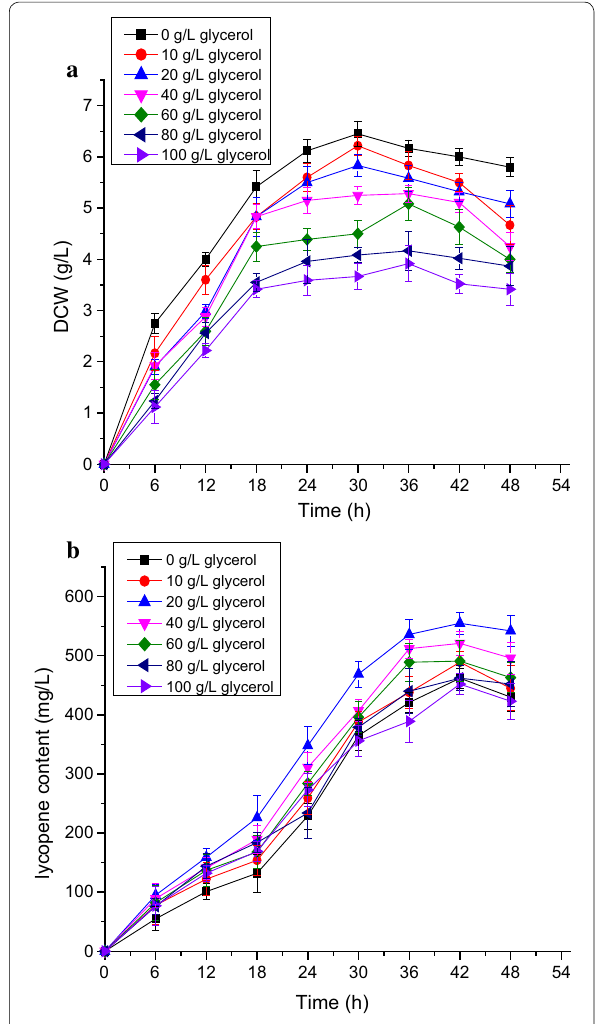
Fig. 5 Dry cell weight and lycopene yield of strain EBI with different initial concentrations of glycerol. a Cell dry weight of EBI in 2 medium with the addition of 0–100 g L − 1 of glycerol after growth at 30 °C for 48 h. b Lycopene production of EBI in 2 the addition of 0–100 g L − 1 of glycerol after growth at 30 °C for 48 h. The data represent the means of three independent experiments. Error bars represent standard